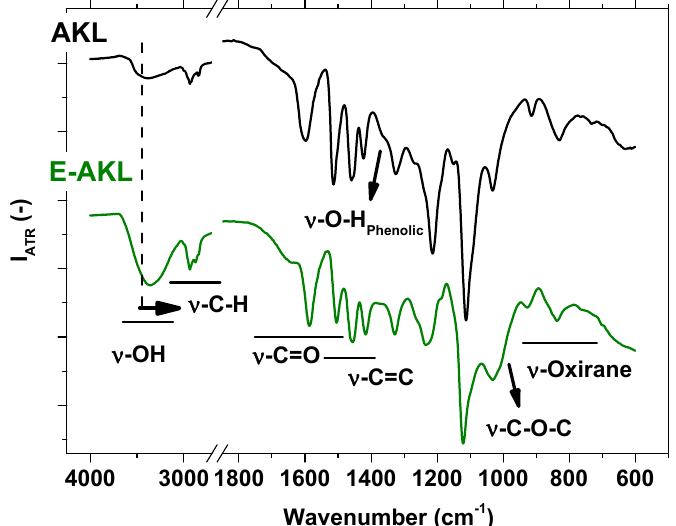
Figure 3. FTIR-ATR spectra of lignin as AKL (top) and E-AKL (bottom) in the 4000–650 cm − 1 wavenumber region.